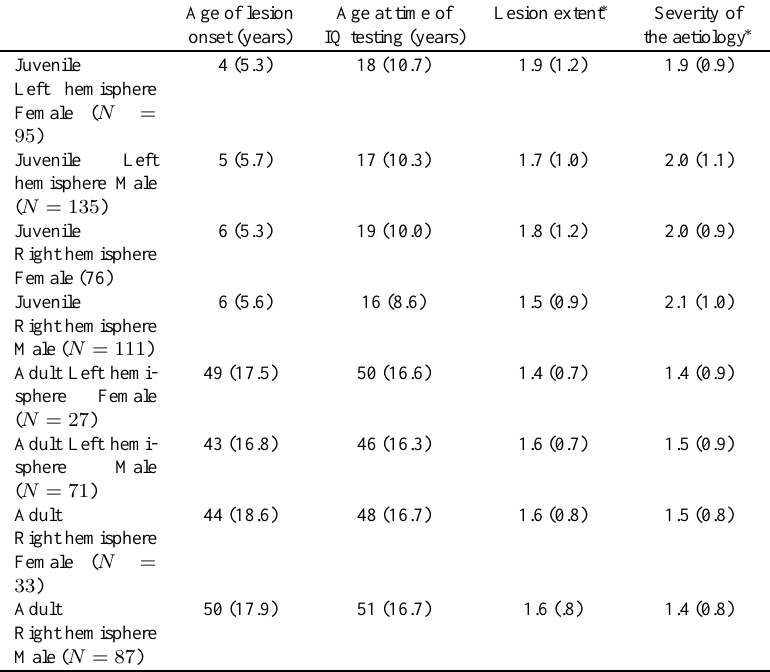
Table 3 Age at lesion onset, age at the time of intelligence testing, lesion extent, severity of the aetiology, as a function of age-group, hemisphere-lesioned and sex (means and SDs) Age of lesion Age at time of Lesion extent